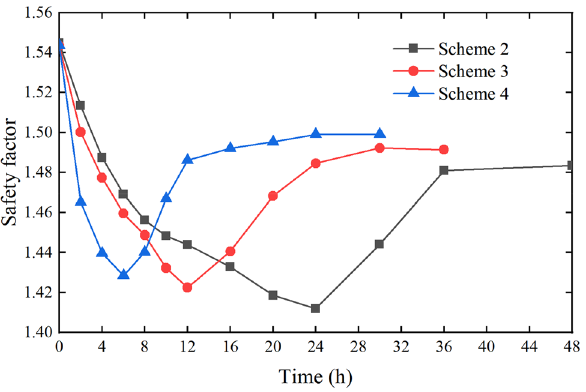
Figure 26. Slope safety factor with time (Scheme II, Scheme III and Scheme